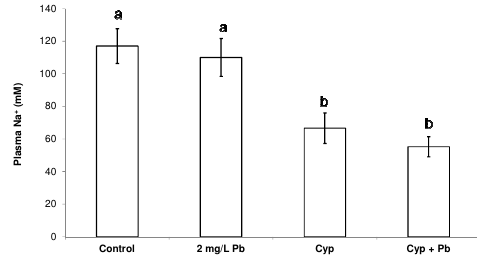
Fig. 1. Mean (±SE, n=6) plasma Na + in C. gariepinus exposed to either borehole water (control), 2 mg/L Pb, 0.5µg/L cypermethrin or 0.5µg/L cypermethrin + 2 mg/L Pb. (n=6). Bars with different letters are significantly